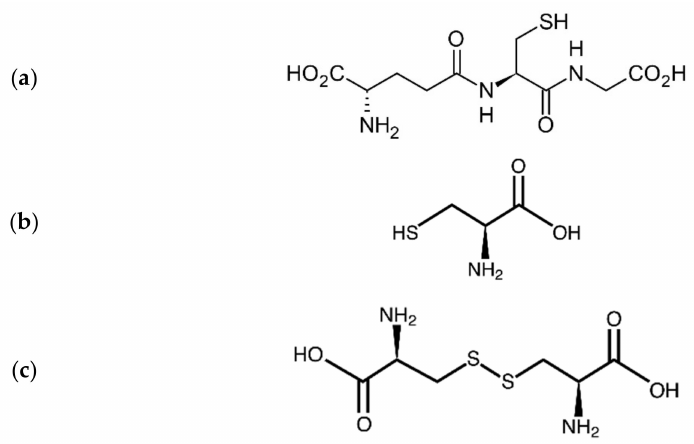
Figure 1. Molecular formulae of ( a ) glutathione, ( b ) cysteine and ( c )